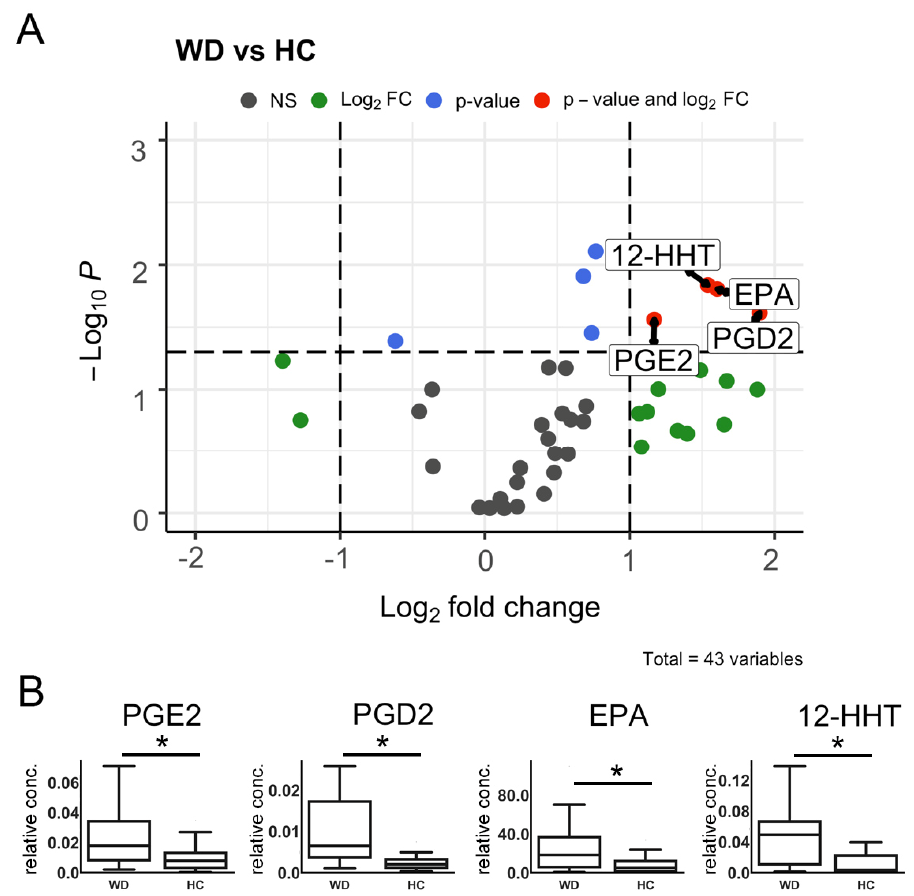
Figure 1. ( A ) Volcano plot indicating significantly changed compounds. The X-axis indicates a log2 fold change of wilson disease WD to HC (healthy control) patients. Y-axis indicates −log10 p -values (adjusted). The cut-off for p -values is indicated based on Bonferroni correction. Compounds that changed insignificantly are indicated in gray, compounds whose means changed in WD (relative to HCs) more than twofold or less than twofold but insignificantly are indicated in green. Red dots stand for compounds, which changed more than twofold and had a p -value (adjusted < 0.05). ( B ) Relative concentrations of separate metabolites that changed significantly in WD patients in comparison with HCs. Pairwise comparison of adjusted means was conducted taking into account the age and sex of patients. * p < 0.05 (adjusted for multiple testing).